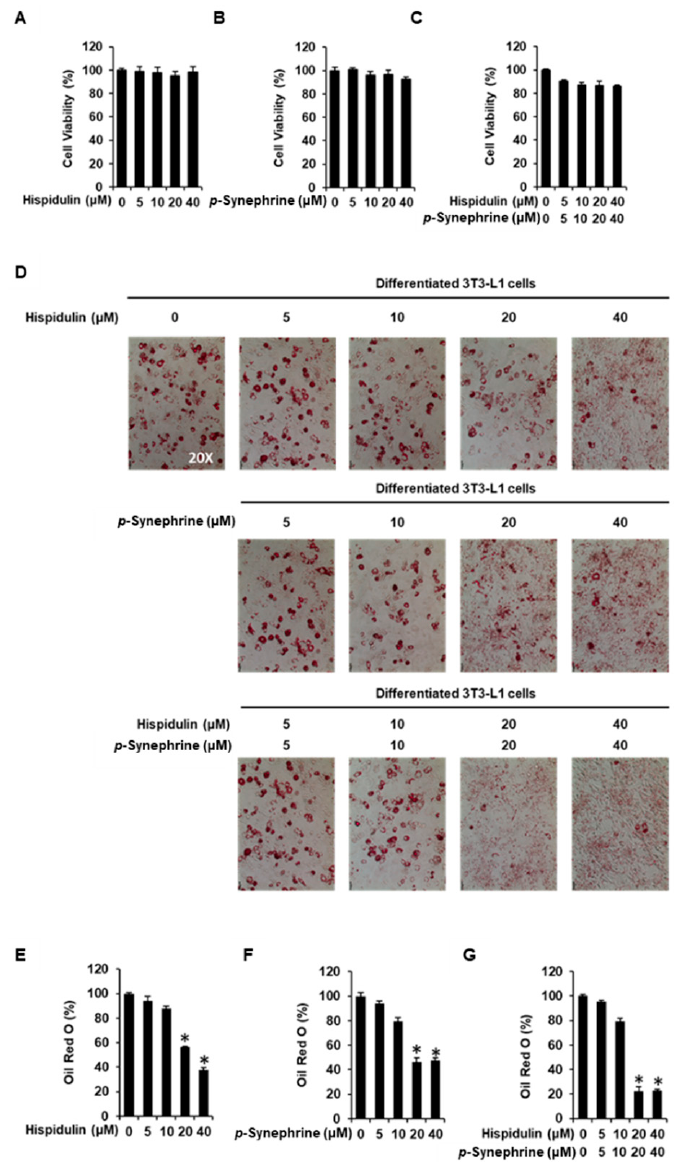
Figure 6. Inhibitory effects of hispidulin and p -synephrine on adipogenesis in 3T3L-1 preadipocytes. Effect of ( A ) hispidulin, ( B ) p -synephrine, and ( C ) combination of hispidulin and p -synephrine on the viability of 3T3L-1 preadipocytes for 24 h by Ez-Cytox cell viability assay. ( D ) Images of the Oil Red O staining of differentiated 3T3L-1 cells imaged under an inverted microscope at 20 × magnification on day 8 after treatment with hispidulin and/or p -synephrine. ( E – G ) Quantification of Oil Red O staining expressed as the percentage of the untreated control ( n = 3 independent experiments, * p < 0.05, Kruskal–Wallis nonparametric test). Data are presented as the mean ±